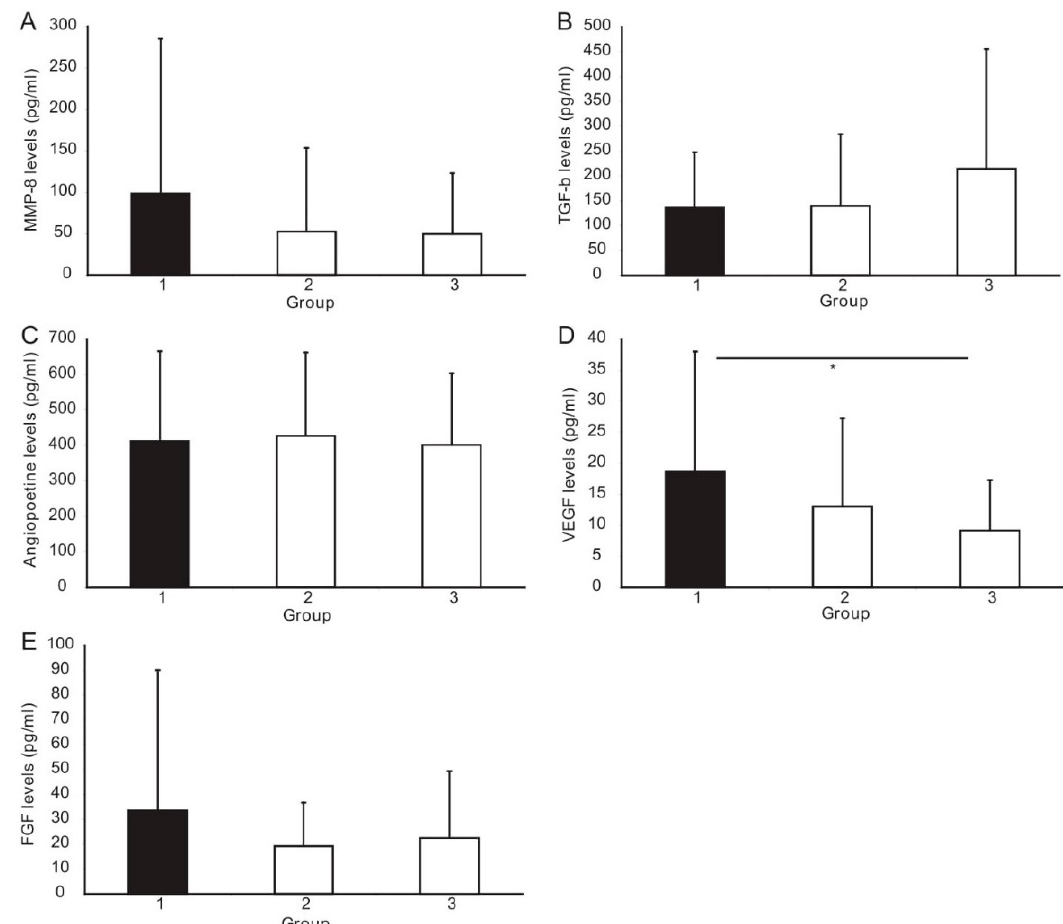
Figure 2. Plasma levels of the investigated angiogenic factors: ( A ) Matrix metalloproteinase-8 (MMP-8); ( B ) Transforming growth factor beta 1 (TGF- β 1); ( C ) Angiopoetine-2; ( D ) Vascular endothelial growth factor (VEGF); ( E ) Fibroblast growth factors (FGF) in patients with coronary artery abnormal dilation (CAAD, Group 1) compared to patients with obstructive coronary artery disease (Group 2), and controls with normal coronary arteries (Group 3). * indicates a significant difference between the groups ( p ≤ 0.05).